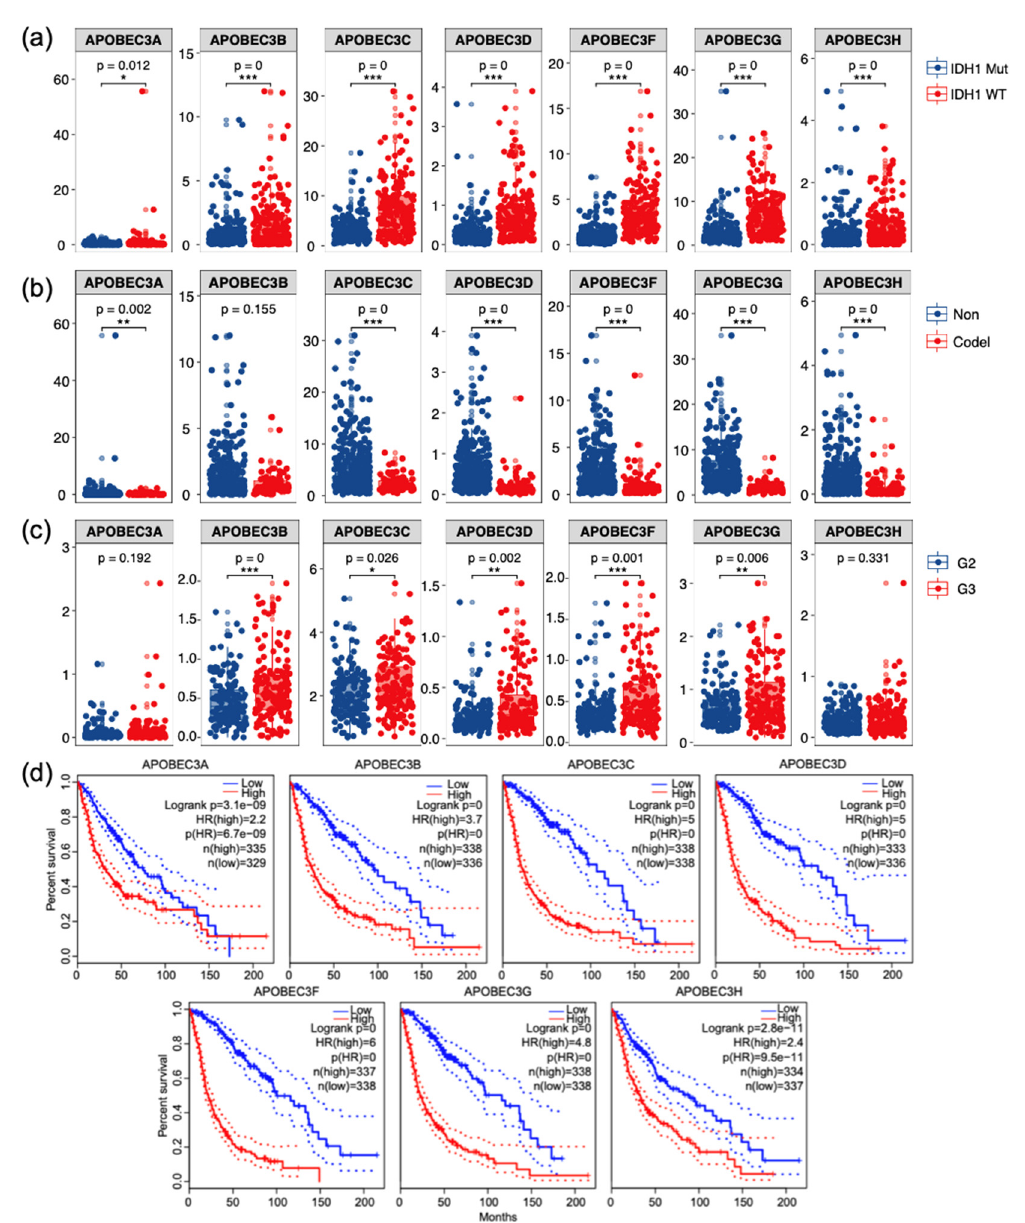
Figure 2. Prognostic features and expression of APOBEC3s in gliomas. ( a ) The expression of APOBEC3 family in the IDH1 wild type group was higher than mutant group. ( b ) The expression of APOBEC3 family in 1p/19q non-codeletion group was significantly higher than codeletion group. ( c ) The expression of APOBEC3 family was upregulated with the increase of tumor grade in LGG. ( d ) The survival curves of APOBEC3 family genes in glioma patients. * p < 0.05, ** p < 0.01, *** p < 0.001.